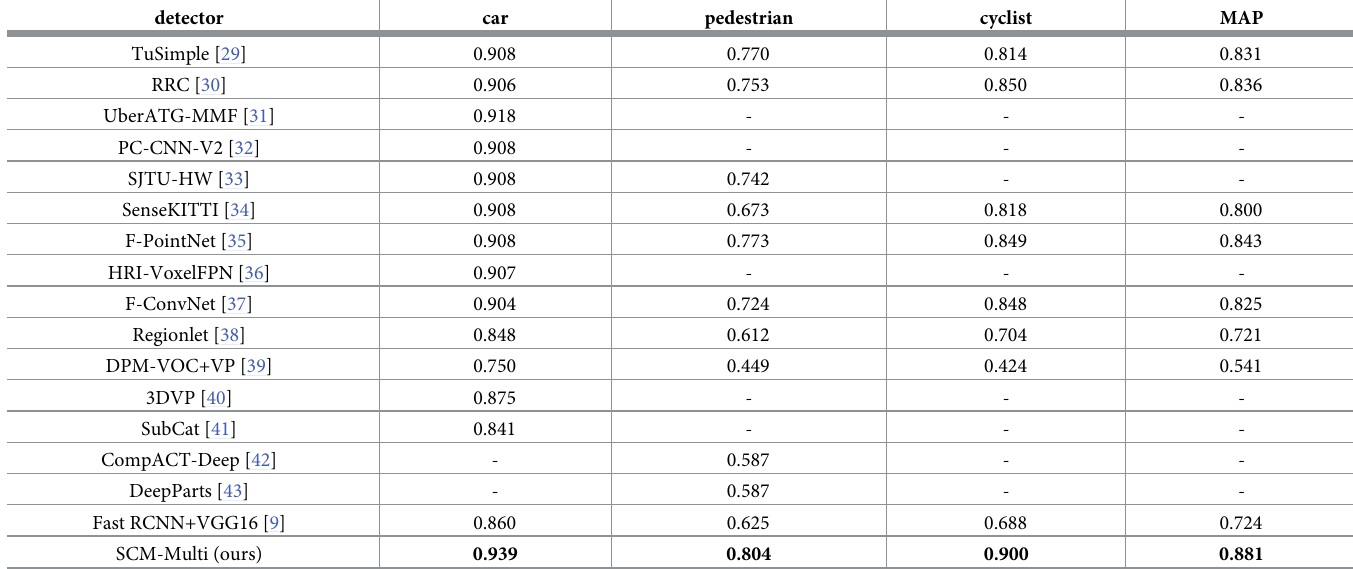
Table 4. Object detection quality comparison of our structural-constraint-applied networks and other detectors on KITTI . detector